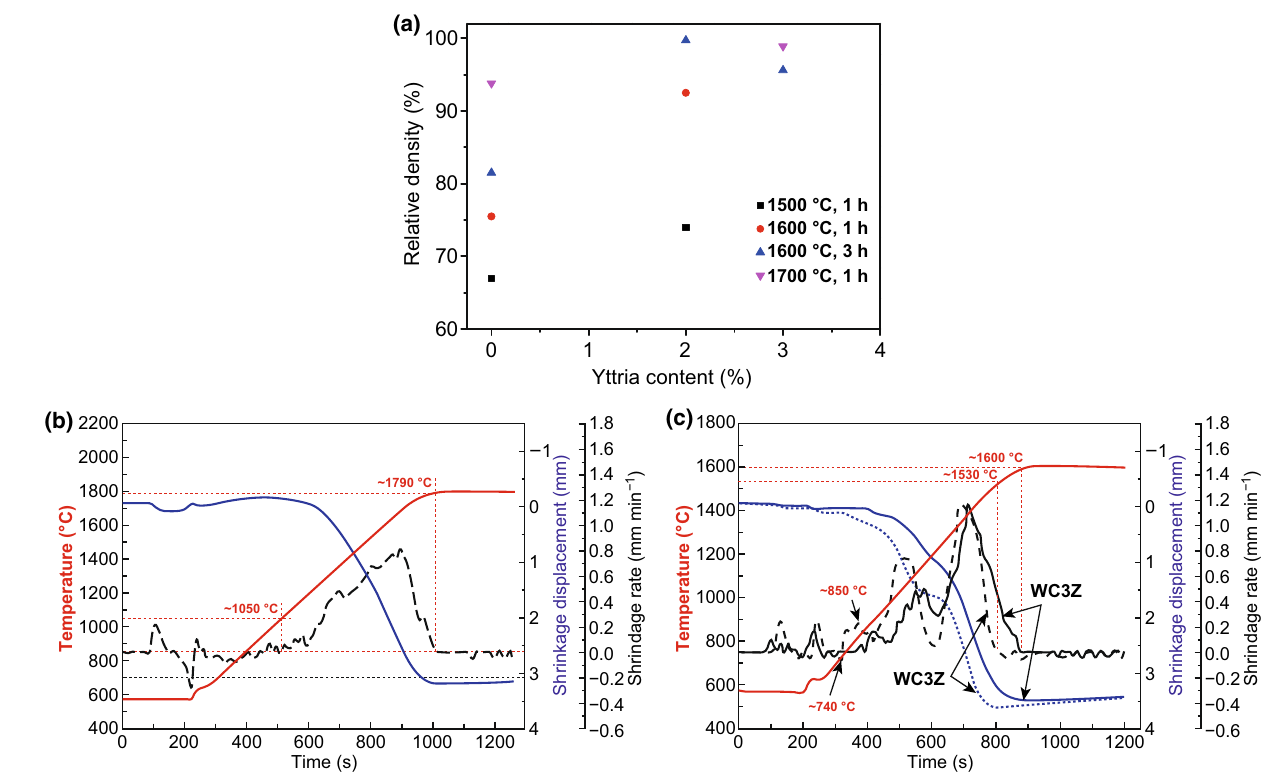
Fig. 7 a Relative density obtained at different sintering temperatures with WC composites with 6 wt% ZrO 2 (stabilized with varying amount of Y 2 O 3 ) sinter‑additive [111]. Densification curves for b pure WC sintered at 1800 °C for holding 5 min, c WC3Z and WC10Z specimens sintered at 1600 °C for holding 5 min [104]. Figure panels reproduced from Ref. [111] with permission from Elsevier copyright 2005, Ref. [104]